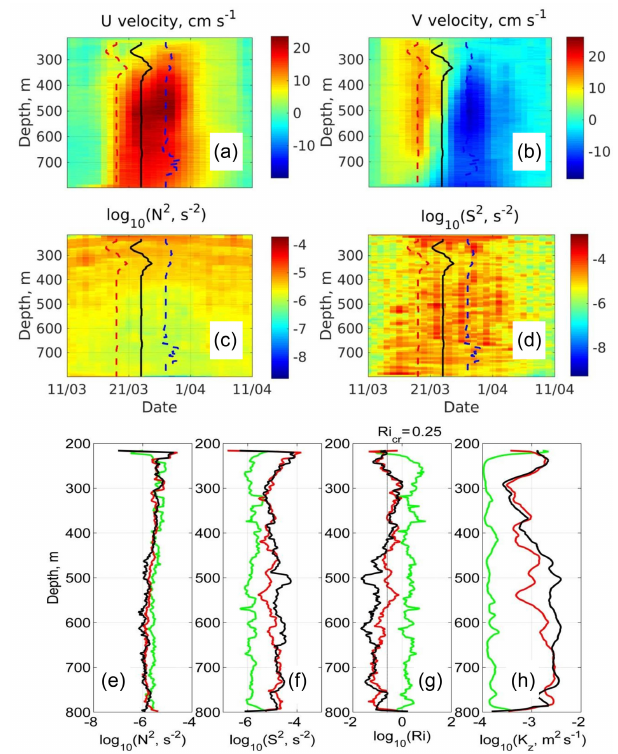
Figure 11. Depth versus time distribution of eastward ( U ; a ) and northward ( V ; b ) velocities, squared buoyancy frequency ( N 2 ; c ), and squared velocity shear ( S 2 ; d ) inside a cyclonic eddy observed at mooring M1f in March–April 2009. Profiles of squared buoy- ancy frequency (e) , squared velocity shear (f) , Richardson number ( Ri , g ), and vertical diffusivity coefficient ( K z , h ) at the frontal edge of a cyclonic eddy (red lines), in its center (black), and outside of an eddy (green). K z values were estimated using the Pacanowski and Philander (1981) parameterization. Data shown in (h) were smoothed using a 21m running mean for better visualization. The frontal and rear eddy edges and the eddy “pseudo” center in (a– d) are shown by red, blue, and black lines,